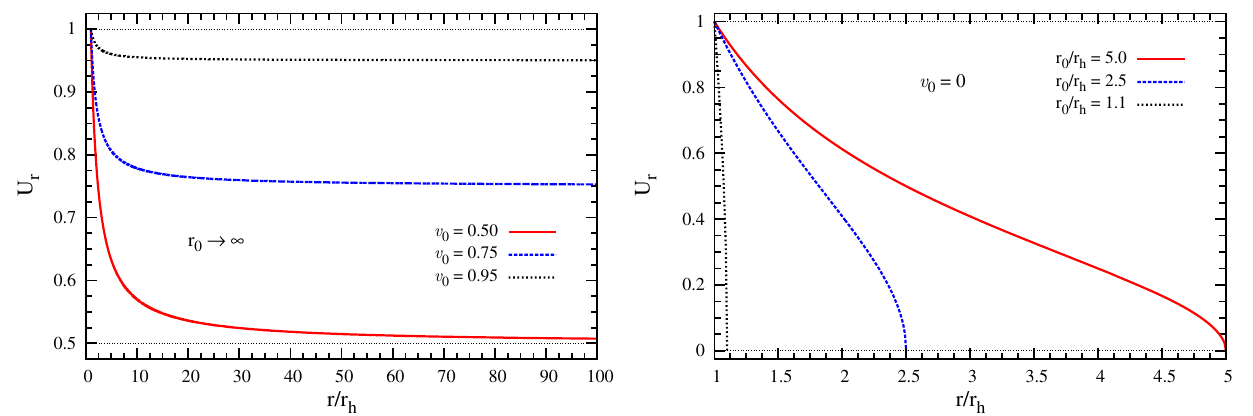
Fig. 1 Modulus of the radial component of the velocity of the source (measured by a static observer, located at r , as a particle passes by her [39]), as a function of r , for a source released from spatial infinity